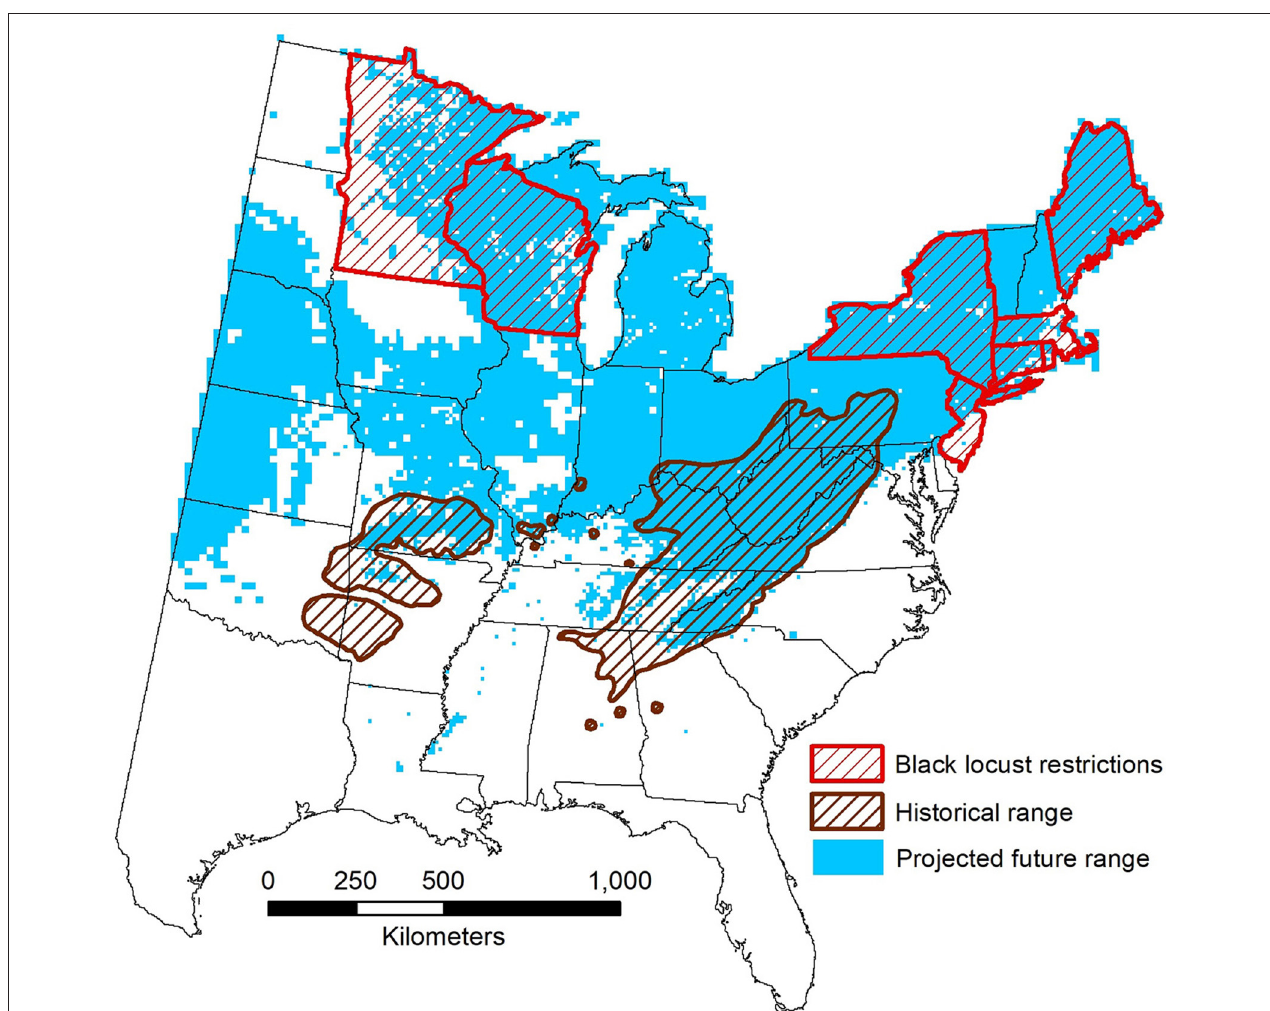
FIGURE 2 | Historical native range (brown polygon) of black locust and its projected future range under a high greenhouse gas emission scenario (blue polygons, Peters et al., 2020). Each state highlighted in red has laws or regulations that require active eradication measures or otherwise restrict the movement of the species (see Supplementary Document 1